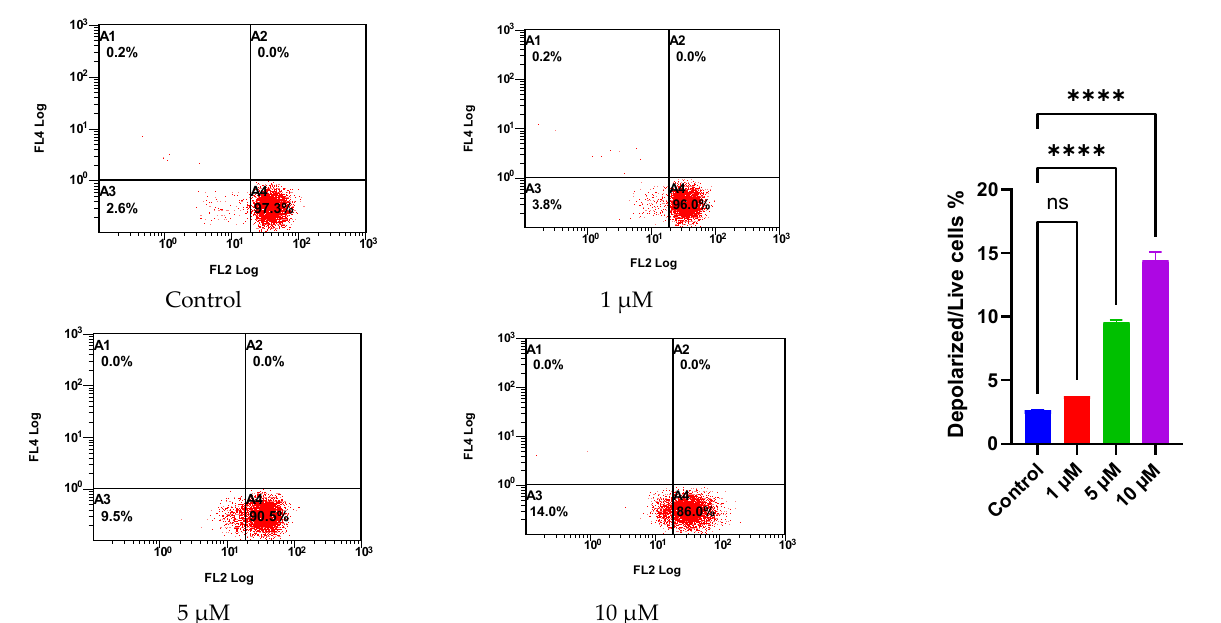
Figure 9. The effect of complex 2 concentrations on mitochondrial membrane potential in MCF-7 cells. The (****) is significant compare to control.